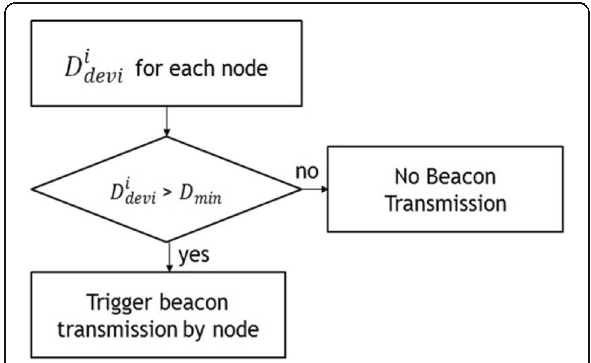
Fig. 3 Flow diagram of Mobility Prediction